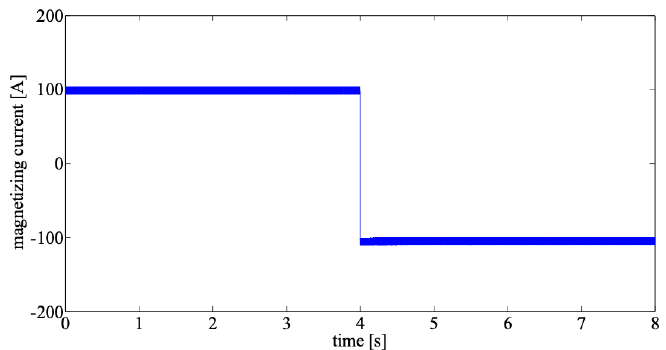
Figure 15. Dynamic behavior of the output voltage (case B).